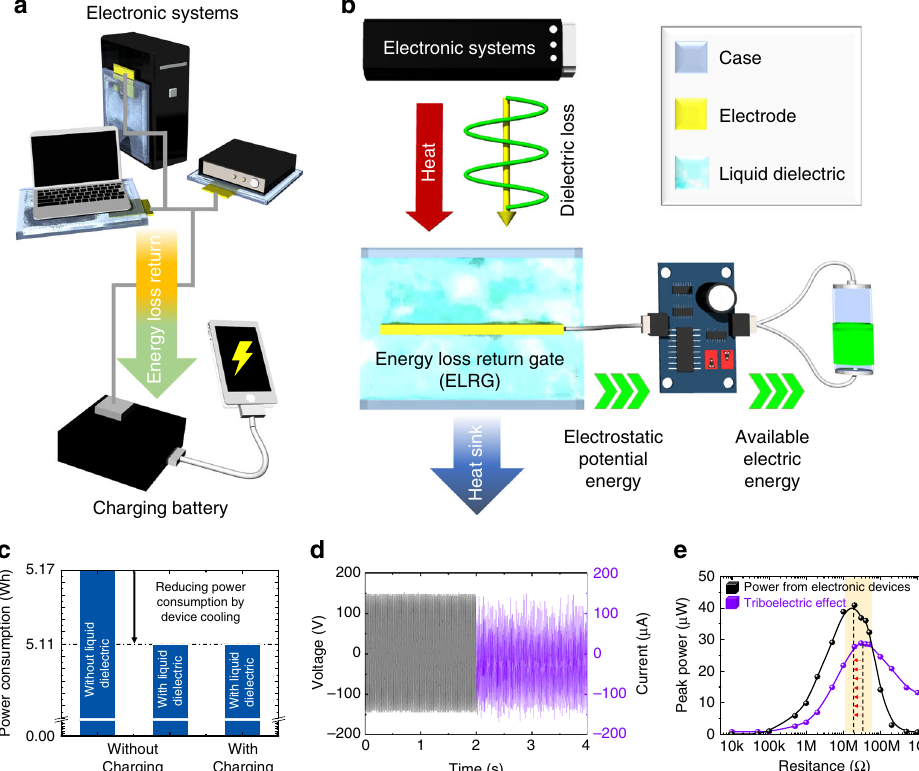
Fig. 5 Operation schemes and electric performances from ELRG process. Electric device is plugged into a 60-Hz AC input electrical source. a Con fi guration of ELRG for practical application. b Operation scheme of ELRG with electric components. c Power consumption measurements from wattmeter. Without liquid dielectric/without charging (left); with liquid dielectric/without charging (middle); with liquid dielectric/with charging (right). Dotted black line represents no difference. d ELRG outputs from the electric device. Open-circuit voltage (left plot); short-circuit current (right plot). e Peak power plots under load resistances. Measurements show the inherent impedance of ELRG and TEG. The difference is highlighted by dashed black lines and red